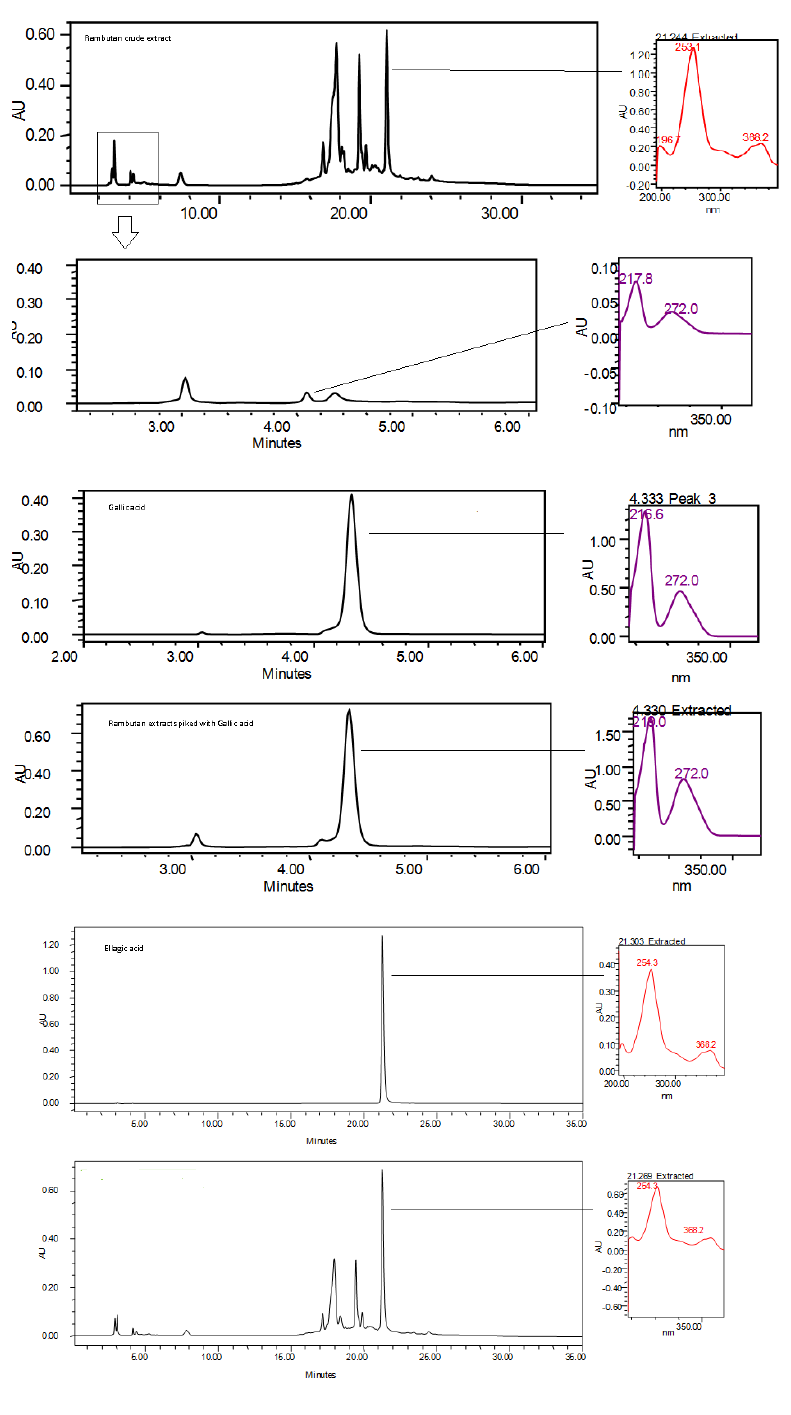
Figure 7. High performance liquid chromatography (HPLC) profiling of rambutan crude